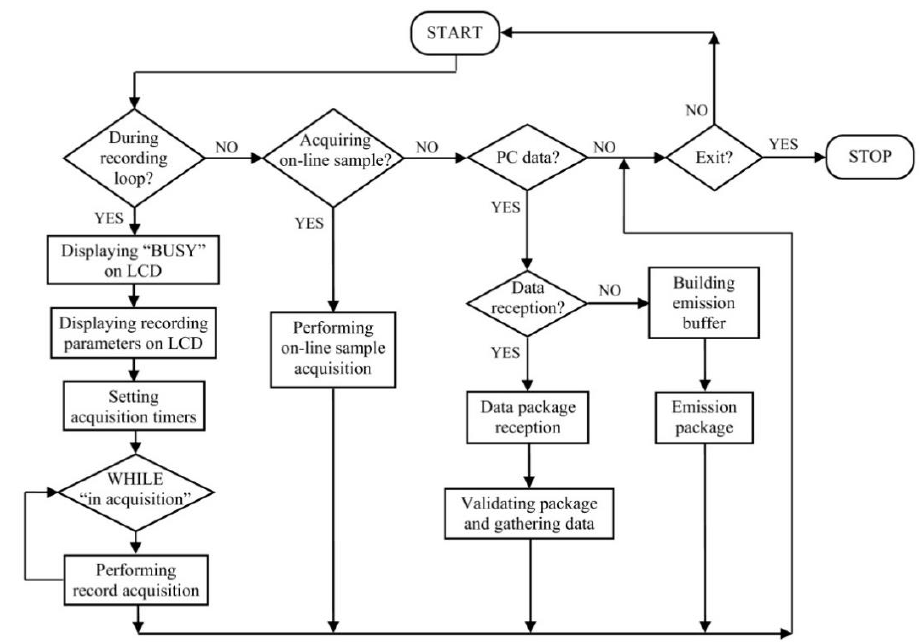
Figure 4. Managing the acquisition and communication interrupt.